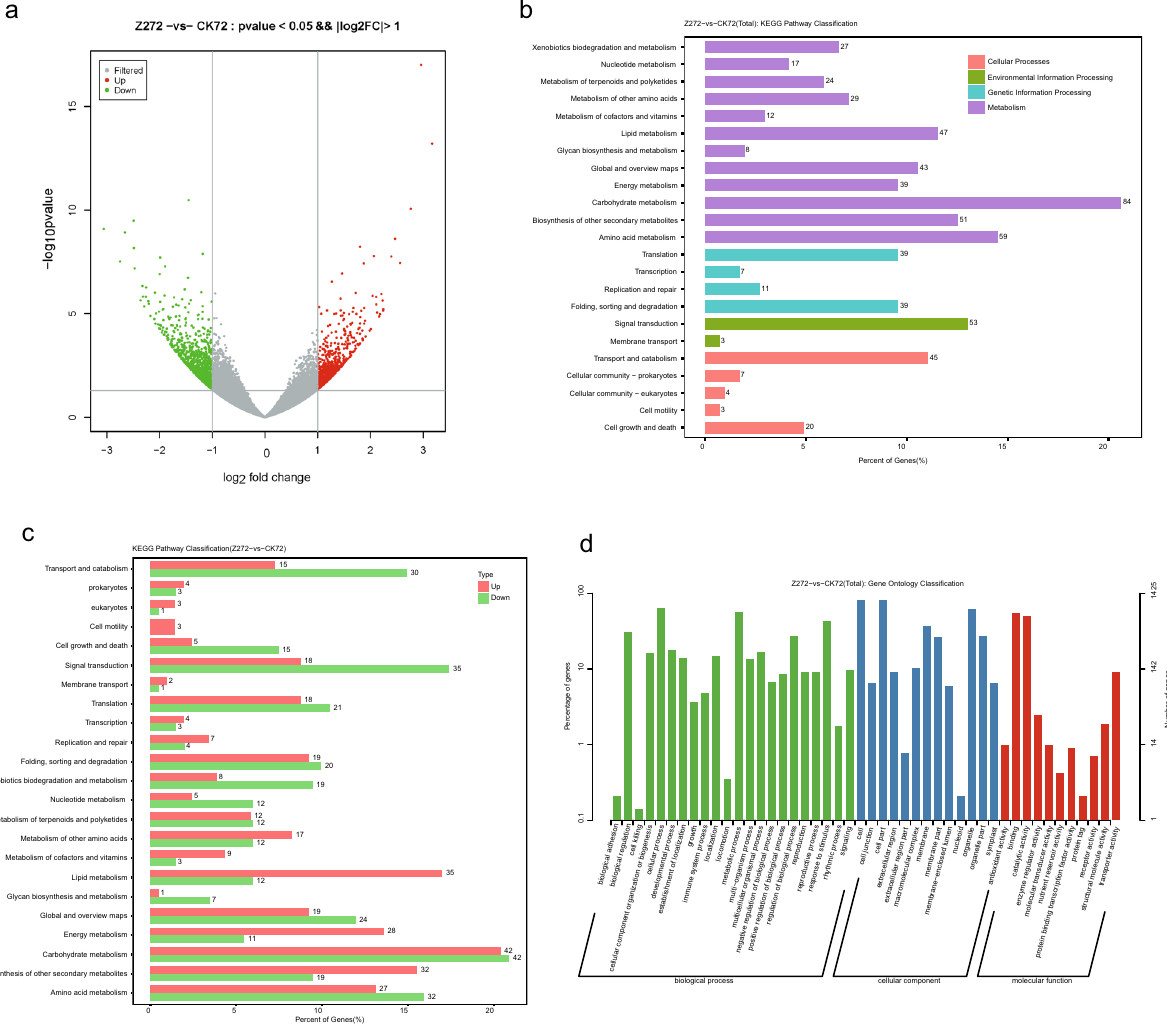
Figure 2. The gene expression of B. napus between control (CK72) and HT-COS (Z272) treatments. ( A ) The volcano plot of differentiated expression genes. ( B ) The KEGG pathway enrichment of DEGs. ( C ) The KEGG pathway enrichment of significantly up-regulated genes. ( D ) The Genes Ontology (GO) enrichment of